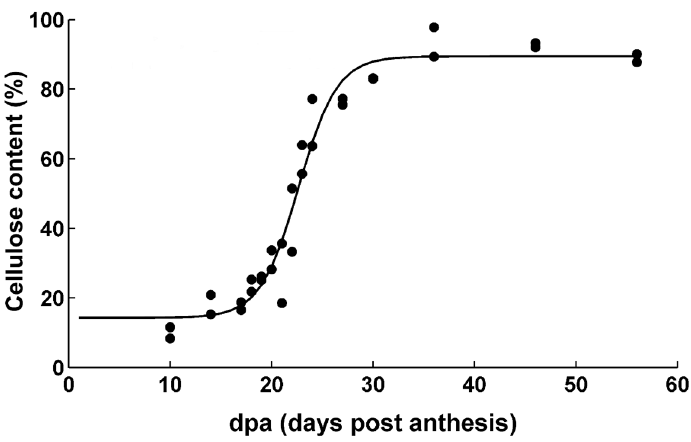
Figure 1. Cellulose content as a function of dpa from TM-1 genotype.